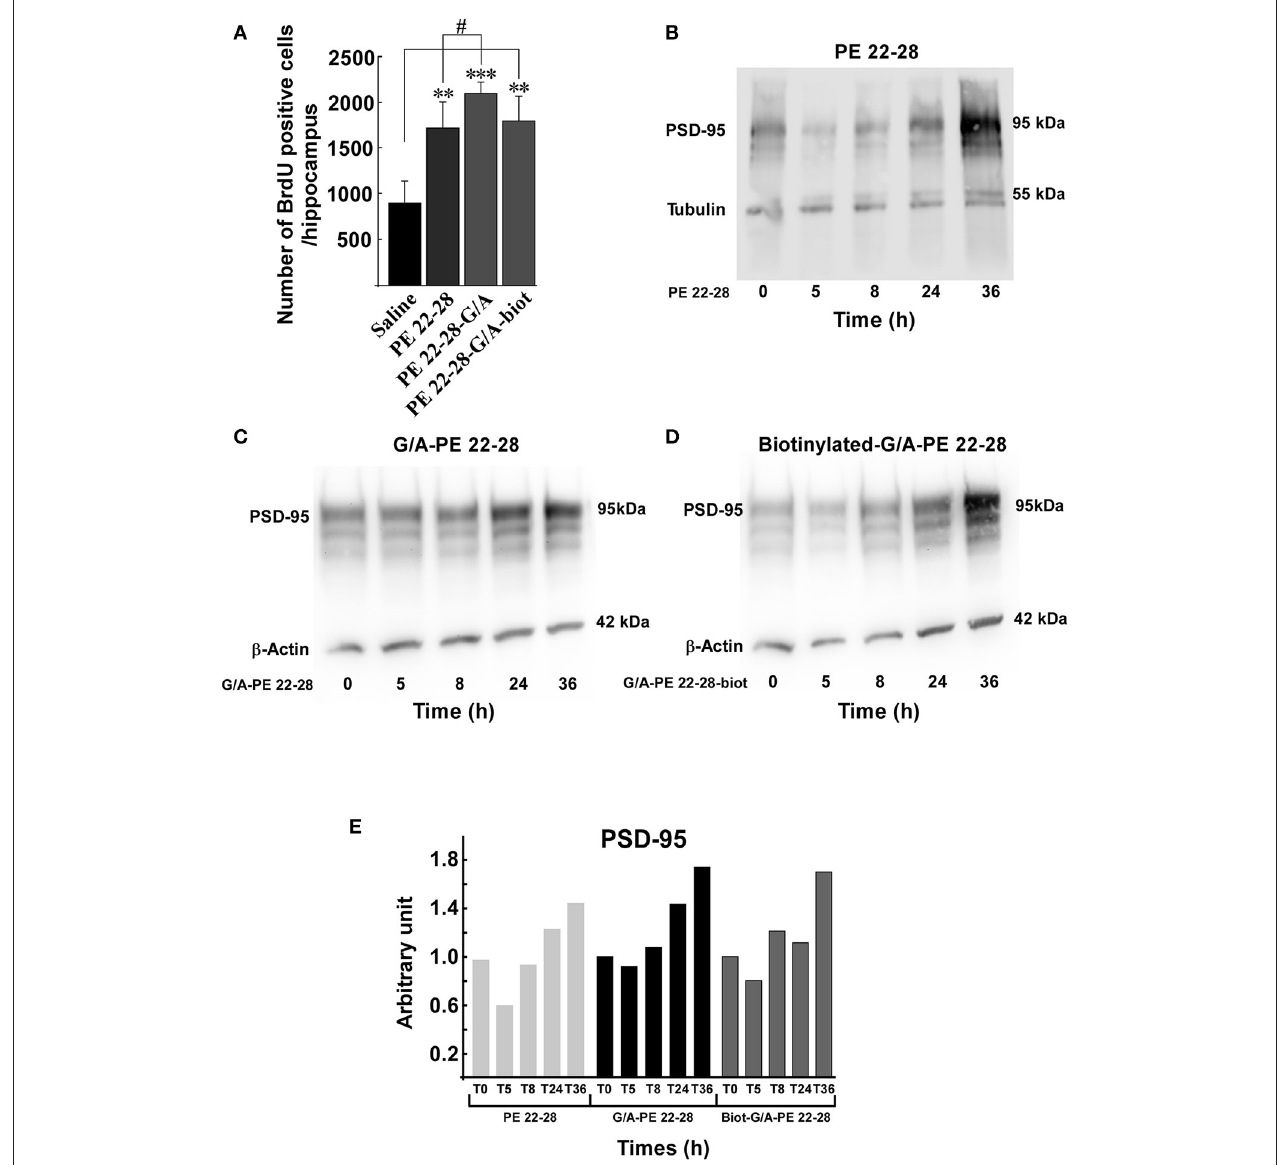
FIGURE 6 | Neurogenesis and synaptogenesis. (A) Neurogenesis was assessed by measuring the number of BrdU positive cells per hippocampus after sub-chronic treatments (3.0–4.0 µ g/kg, 4 days) with spadin-analogs. The cell number was given for the entirety of hippocampus. ** p < 0.01, *** p < 0.001, # p < 0.05. (B–D) Synaptogenesis was assessed by measuring the increase in the level of PSD-95 in mouse cortical neuron. Mouse cortical neurons were treated with 0.1 µ M of the indicated spadin-analog PE 22-28 (B) , G/A-PE 22-28 (C) and biotinylated-G/A-PE 22-28 (D) . At the indicated times neurons were homogenized in Laemmli buffer and submitted to Western blot analysis. (E) Histogram illustration of the PSD-95. For each spadin-analog, the PSD-95 amount at 36 h was about twice than that measured at